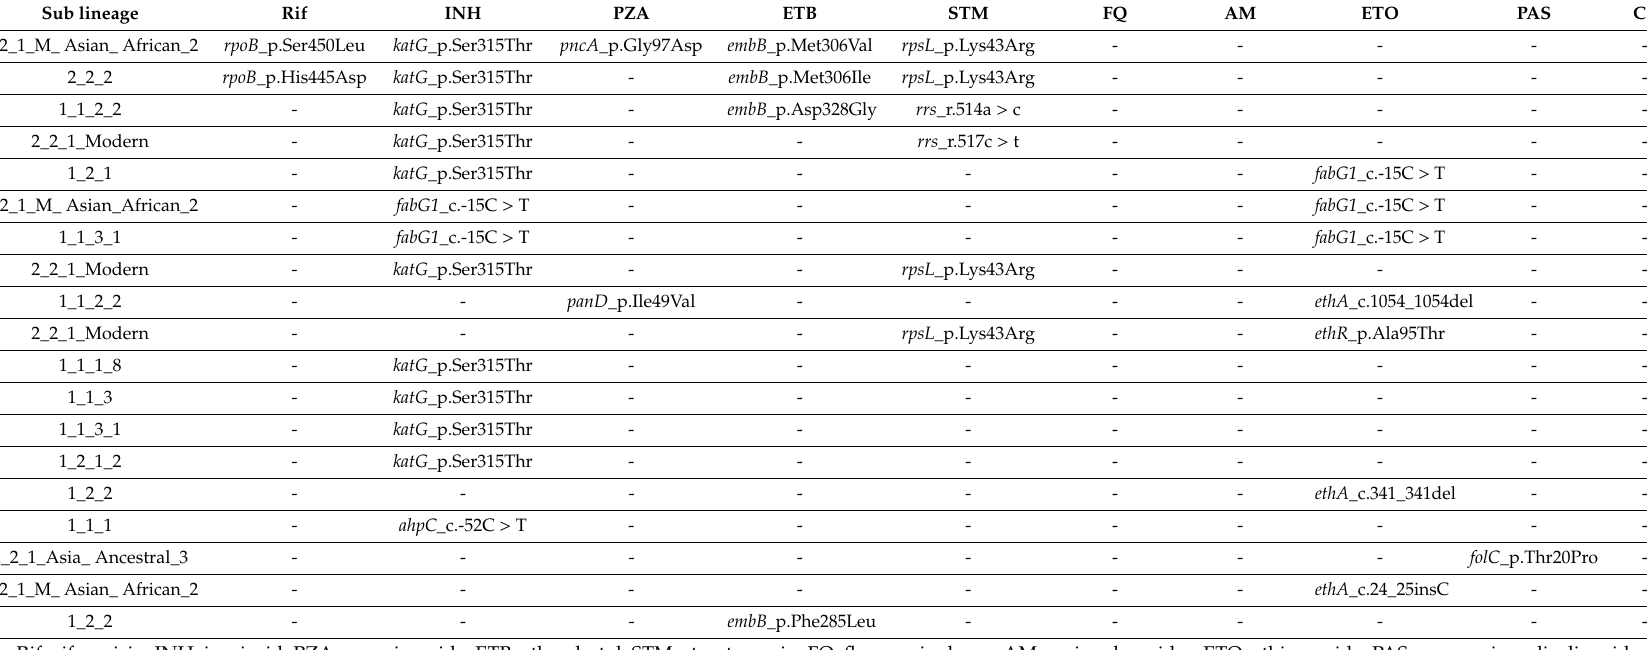
Table 6. Identified Variants Associated with Drug Resistance in the Genomes of the 19 Clinical Mycobacterium tuberculosis Complex Isolates. Sub